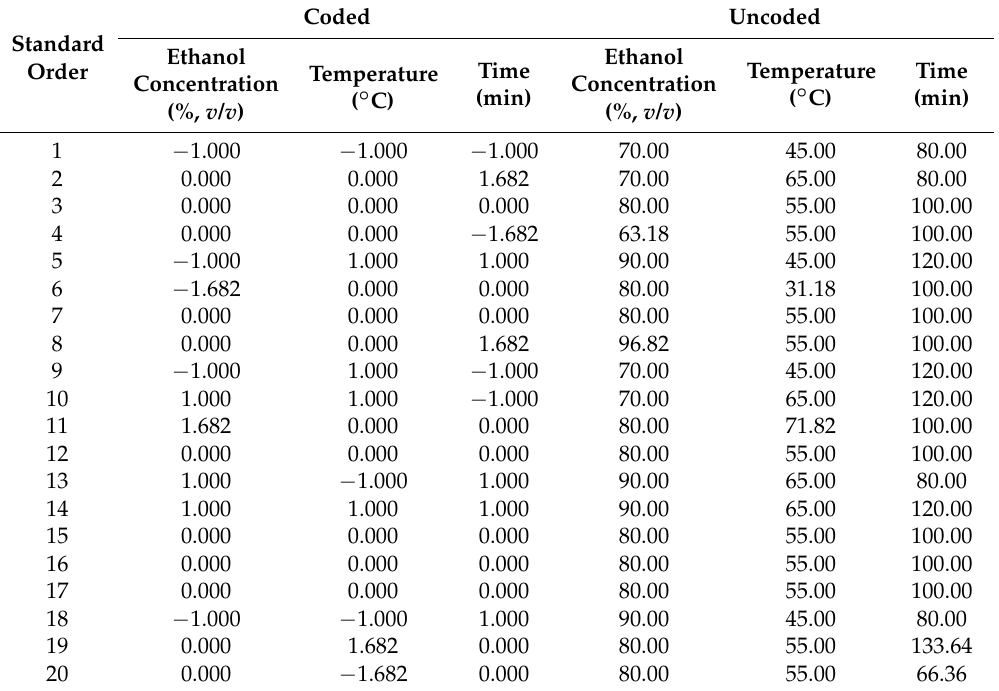
Table 1. The experimental design in coded and uncoded form for the optimization of variables using Central Composite Rotatable Design